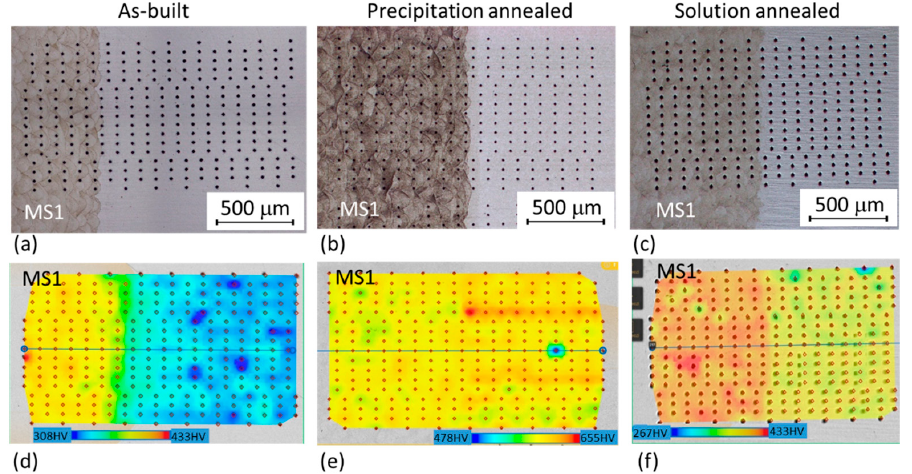
Figure 12. Microhardness mapping: ( a , d ) as-built; ( b , e ) precipitation annealed; and ( c , f ) solution annealed hybrid parts; ( a – c ) micrographs of the tested areas; and ( d – f ) corresponding microhardness maps across the joint between the AM and conventional steels.